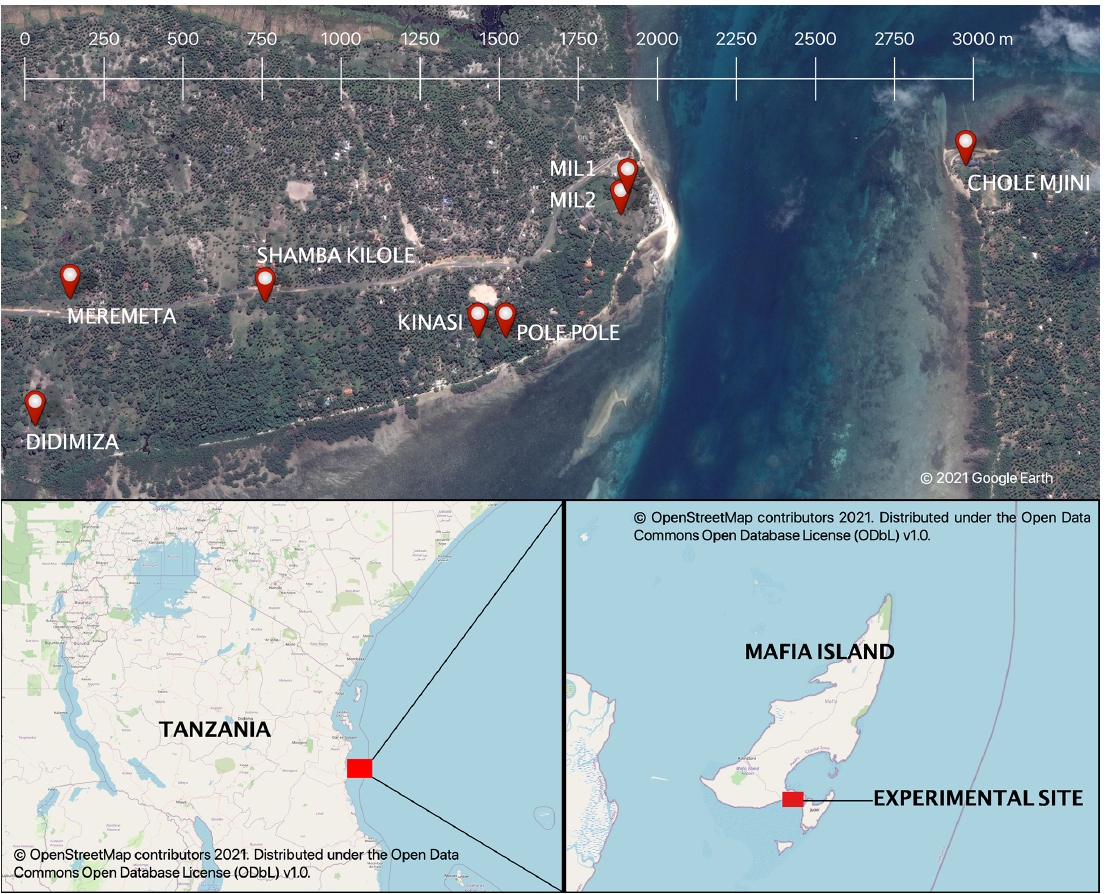
Figure 1. The eight intervalometer sites on Mafia Island, off the coast of Tanzania. Each site contains one intervalometer. Pole Pole also had